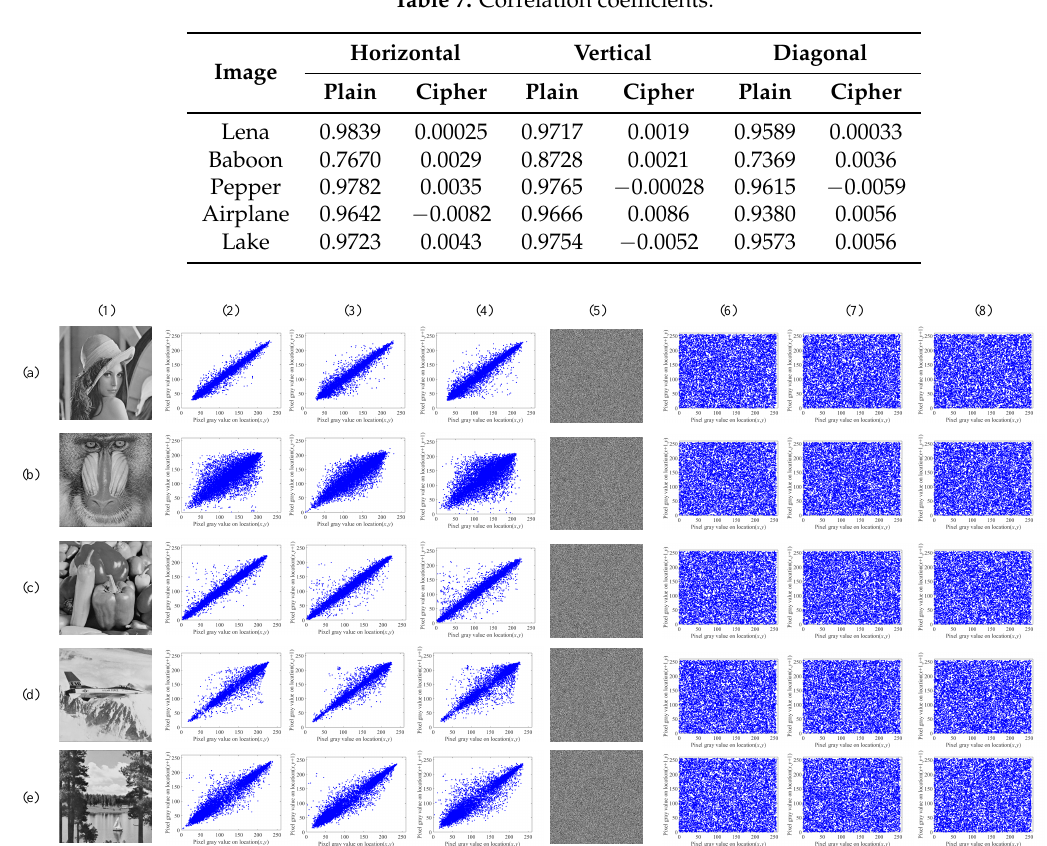
Table 7. Correlation coefficients.